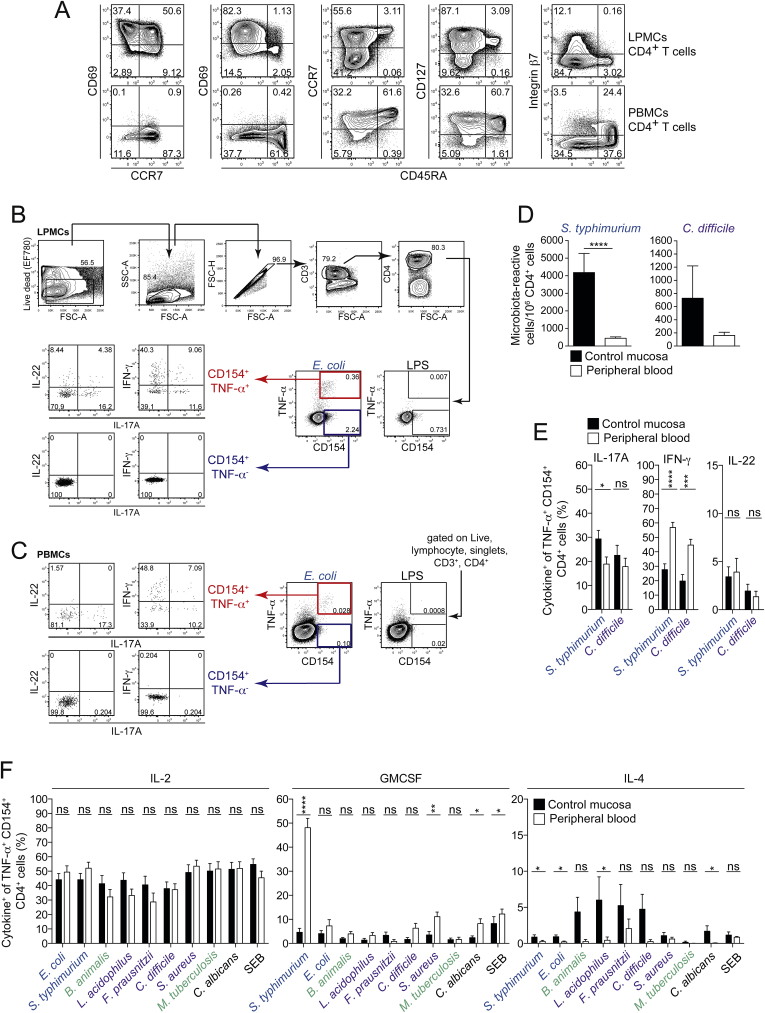
Detection and characterization of microbiota-specific CD4+ T cells within gut-resident memory T cells (related to Figure 3). (A) Representative flow cytometry plots showing CD45RA, integrin β7, CD69, CCR7, and CD127 expression in gut-resident CD3+CD4+ T cells. Data representative of 10 independent donors. (B, C) Gating strategy for identification of enteric bacteria-specific memory CD4+ T cells in lamina propria mononuclear cell (LPMCs) and PBMCs after stimulation with heat-inactivated E coli in a representative donor. (D) LPMCs were stimulated with heat-inactivated bacteria and analyzed for CD154 expression. Estimated gut resident microbiota-reactive cells per million CD4+ T cells compared with adult blood is depicted (n = 17 for control mucosa; n = 25−31 for blood). (E, F) Cytokine production by CD4+CD154+TNF-α+ T cells after short-term stimulation with the indicated heat-inactivated bacteria. Frequencies (±SEM) of 10−23 independent donors. Significance calculated between the respective stimulations in control mucosa and peripheral blood. Statistics: (D, E, F) Mann-Whitney test; ns, not significant; ∗P ≤ .05; ∗∗P ≤ .01; ∗∗∗P ≤ .001; ∗∗∗∗P ≤ .0001.